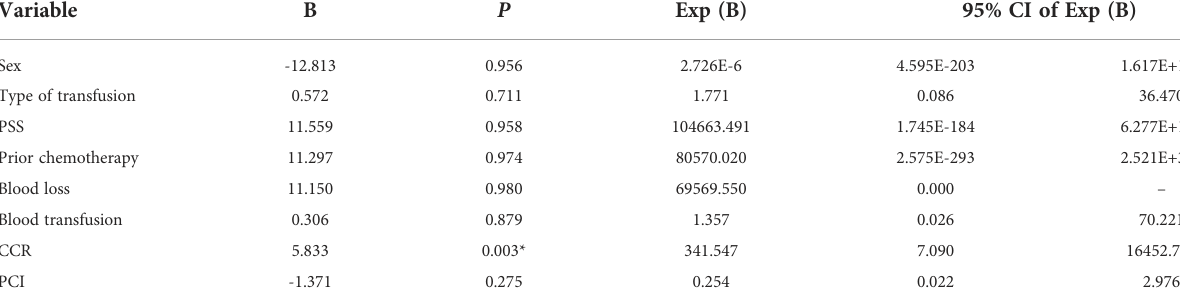
TABLE 2 Multivariate correlation analysis of the factors affecting postoperative recurrence. Variable